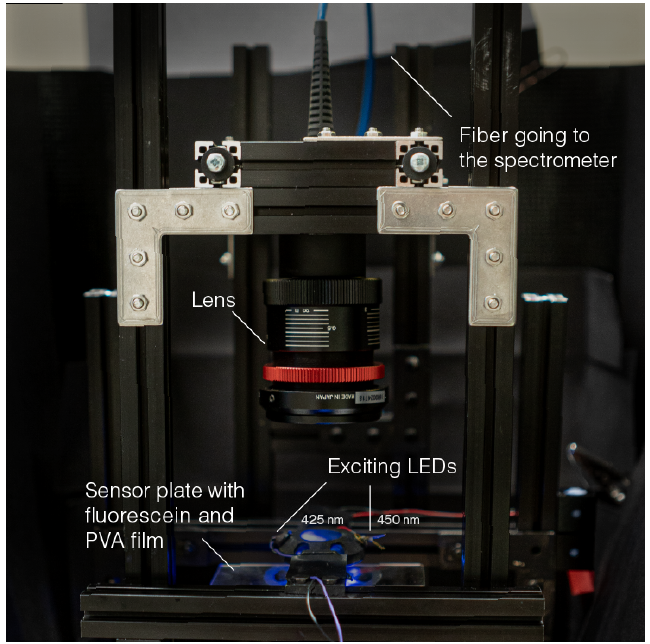
Figure 2. The assembled droplet spectrum measurement device. For photography, the lens and fiber setup was exchanged with a trinocular microscope.